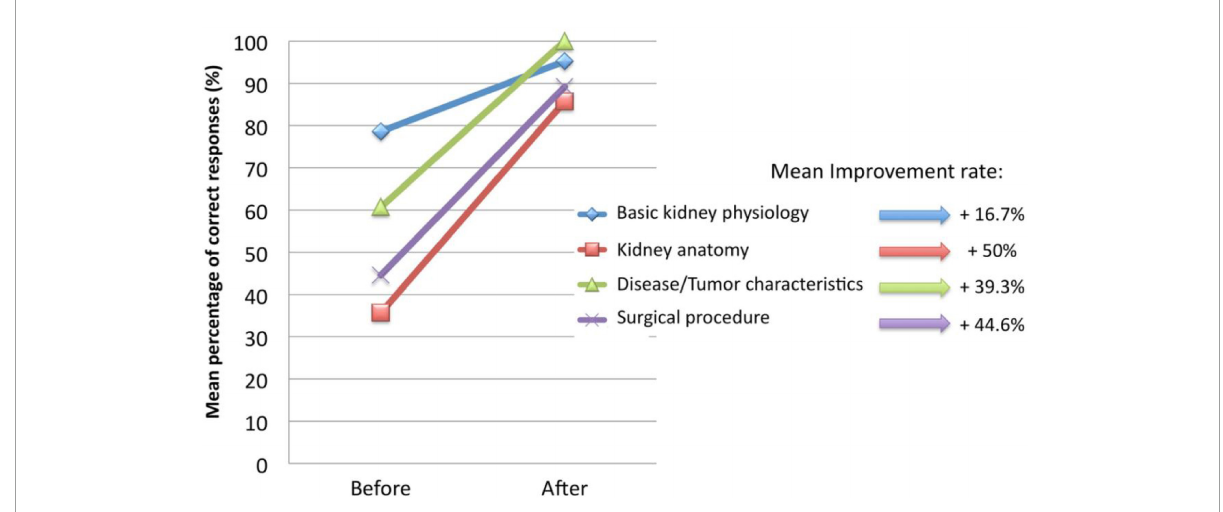
FIGURE2 Patients’ understanding changes in several aspects before and after using the 3D printing model